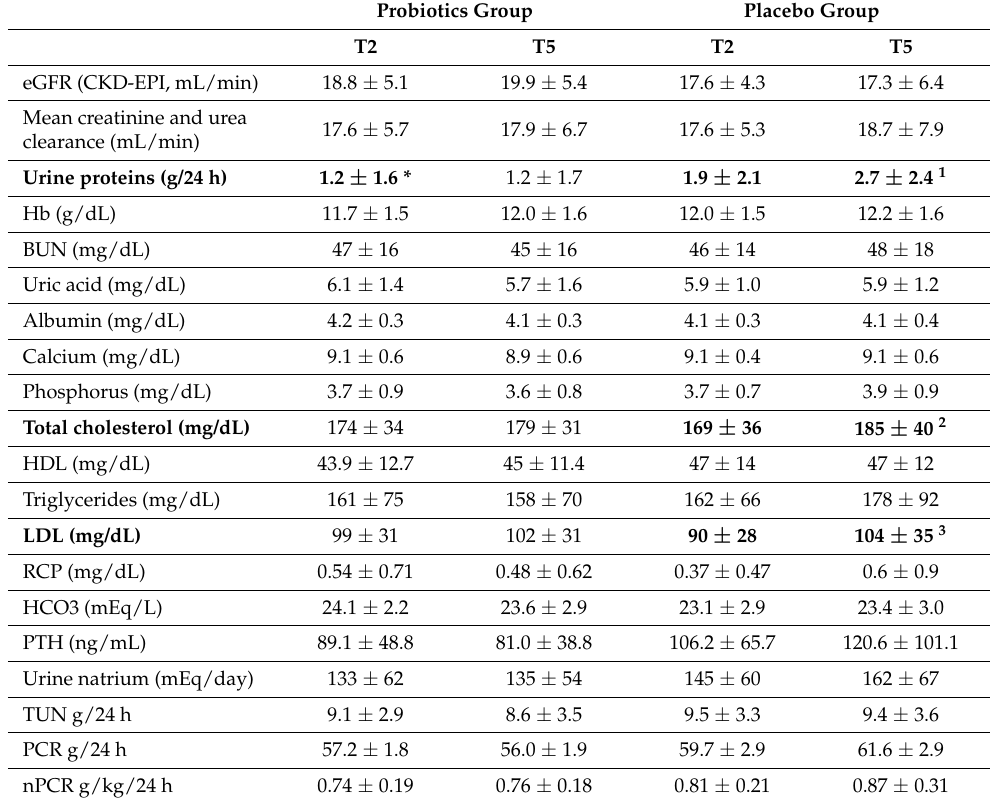
Table 4. Changes in biochemical parameters. Values are presented as mean ± SD.